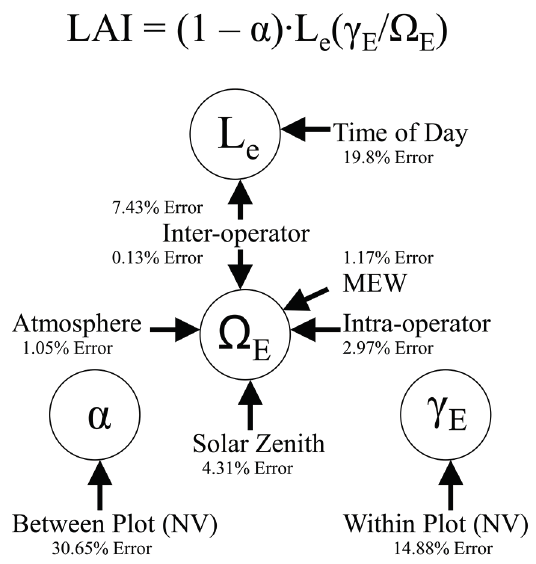
Figure 7. Error components within the modified Beer-Lambert LAI light extinction function for P. taeda . NV—natural